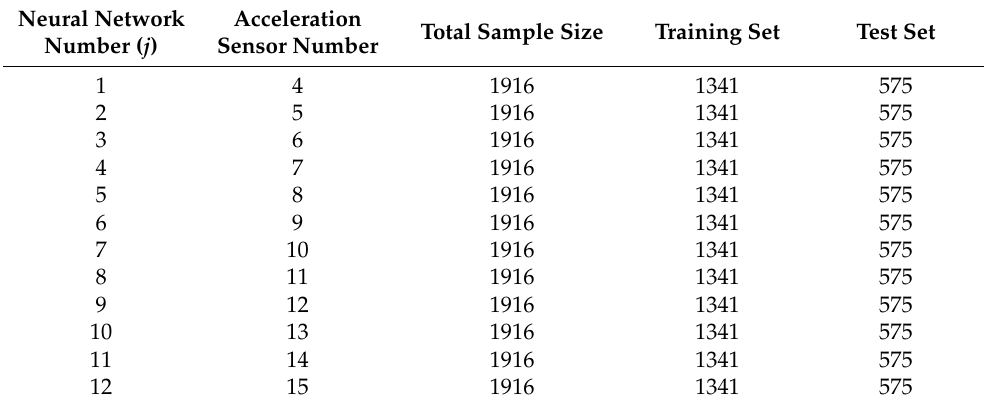
Table 2. Training